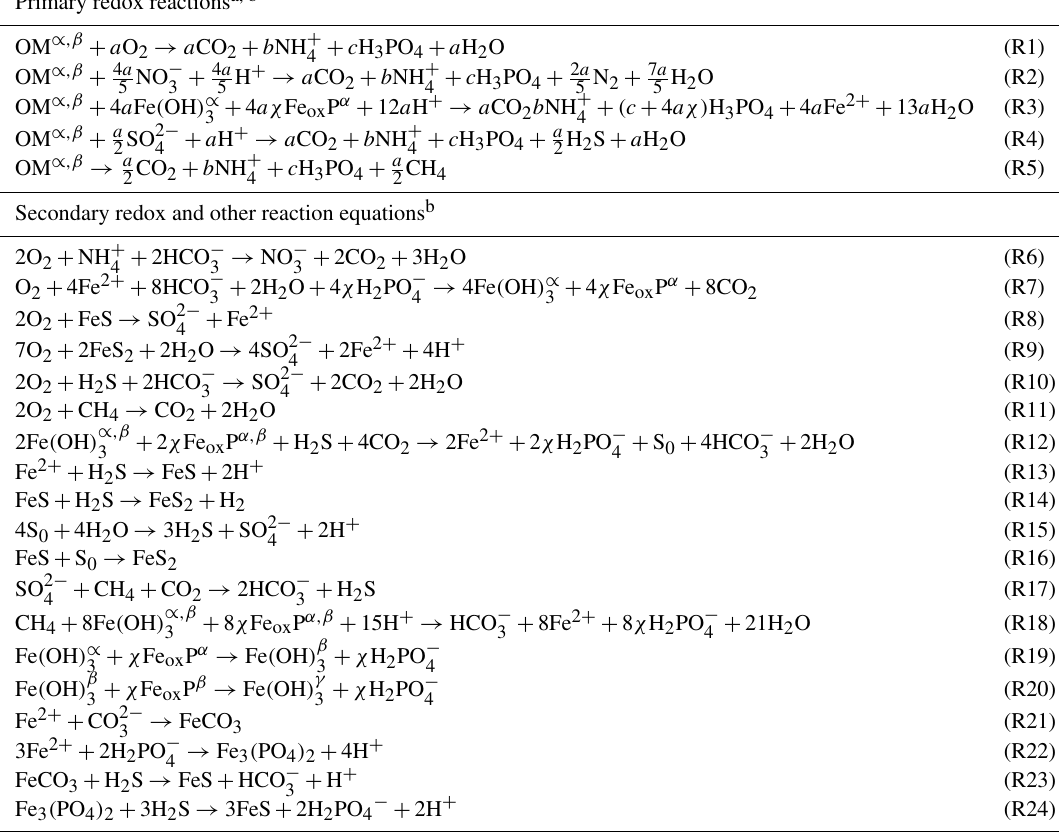
Table 5. Reaction pathways and associated stoichiometries implemented in the diagenetic model. Primary redox reactions a,